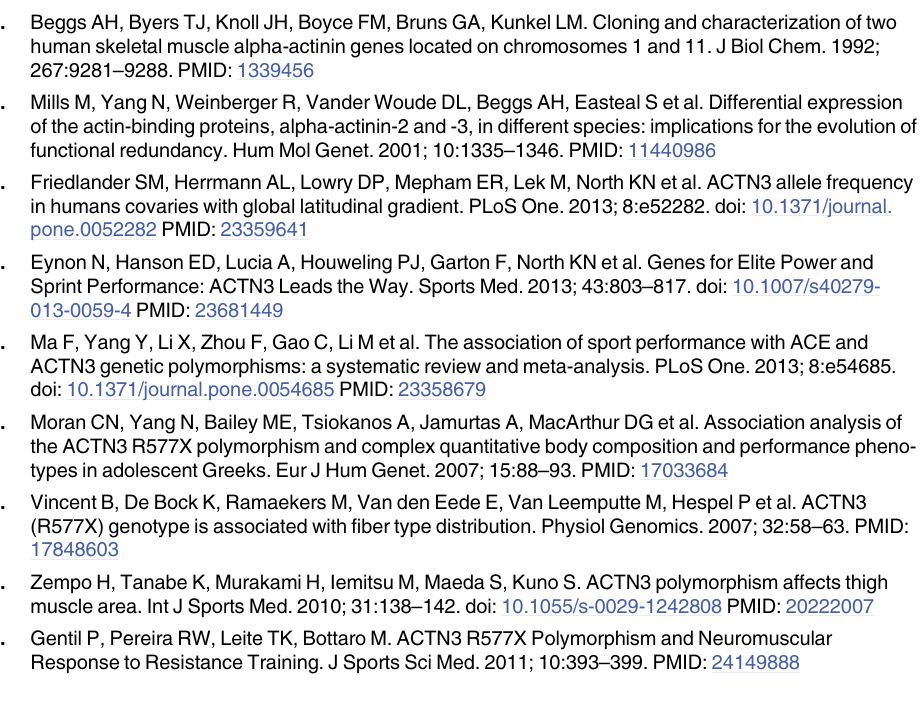
S1 Table. Properties of single muscle fibers with mixed MHC-isoforms in participants with RR and XX genotypes. Values are means±SE. n.a. = not